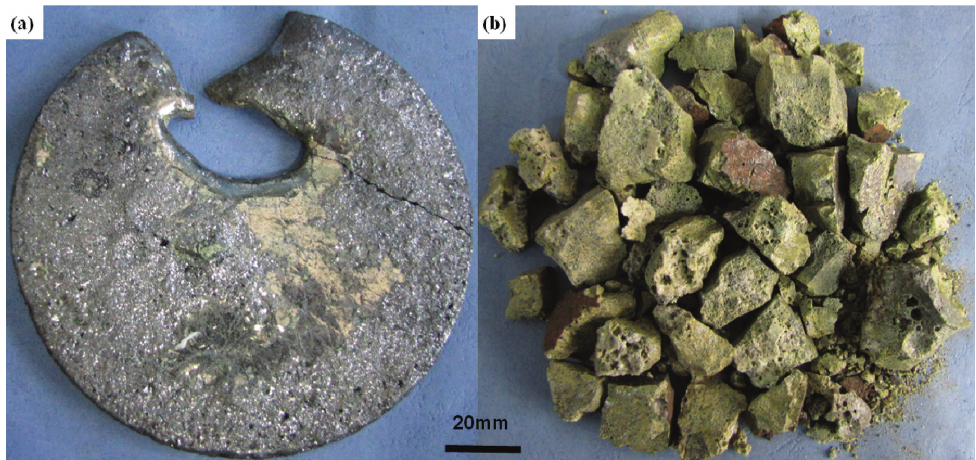
Fig. 4: Morphology of iron nugget and rare-earth-rich slag: (a) iron nugget; (b) rare-earth-rich